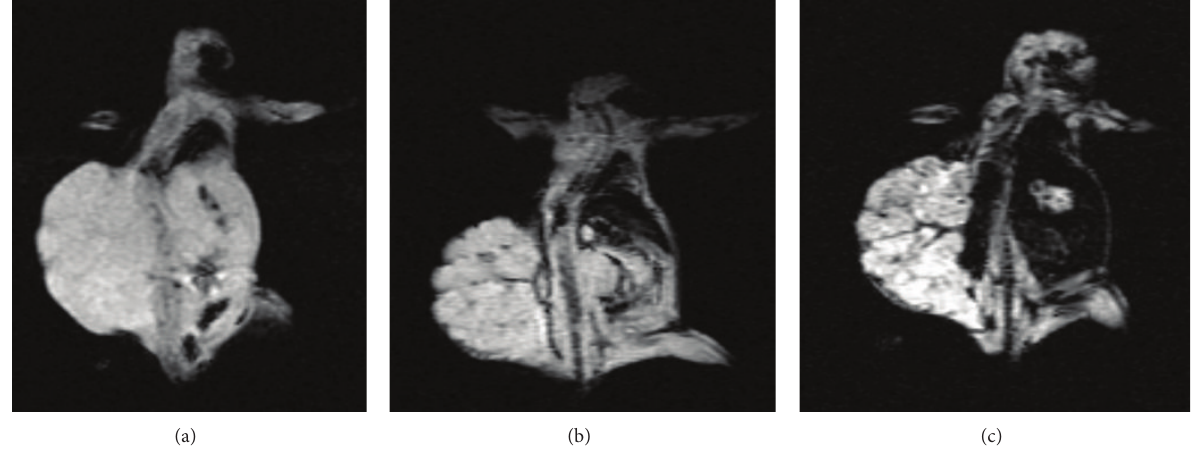
Figure 8: MR image of mice: (a) before injection of agents, (b) after injection of Nanomag-D-SPIO, and (c) after injection of C595-SPIONs.